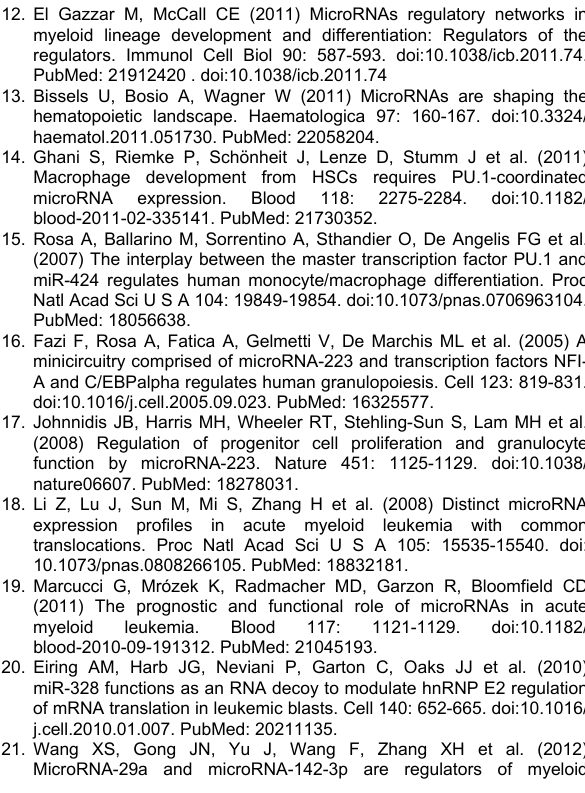
Table S3. Top statistically significant gene expression changes concordant in PL21, HL60, and THP1 cells. Top statistically significant gene expression changes are displayed as concordant in PL21, HL60, and THP1 cells (S3A) or concordant in PL21 and THP1 cells (S3B). The z-score refers to the statistical significance of the difference in expression in either PL21 cells or HL60 cells. Green text represents decreased expression in miR-150 cells as compared to control cells and red text represents increased expression.